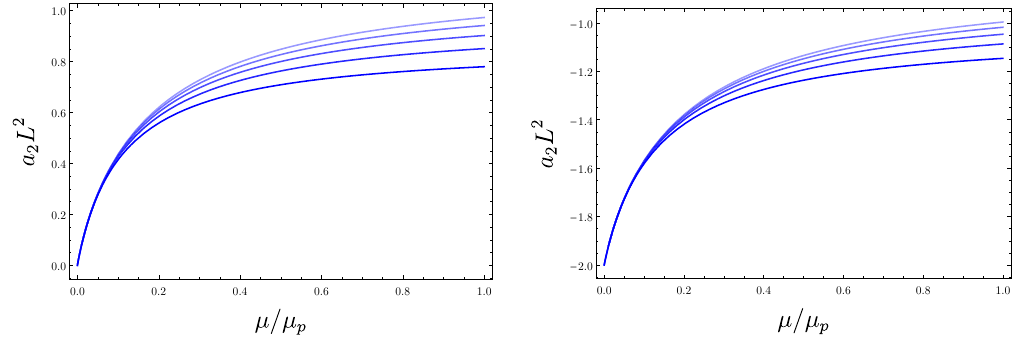
Figure 24 . Shooting parameter vs. coupling : a dimensions. In all cases, the curves illustrate [3 / 3] to [7 / 7] order Pad´e approximants (more to less opacity,